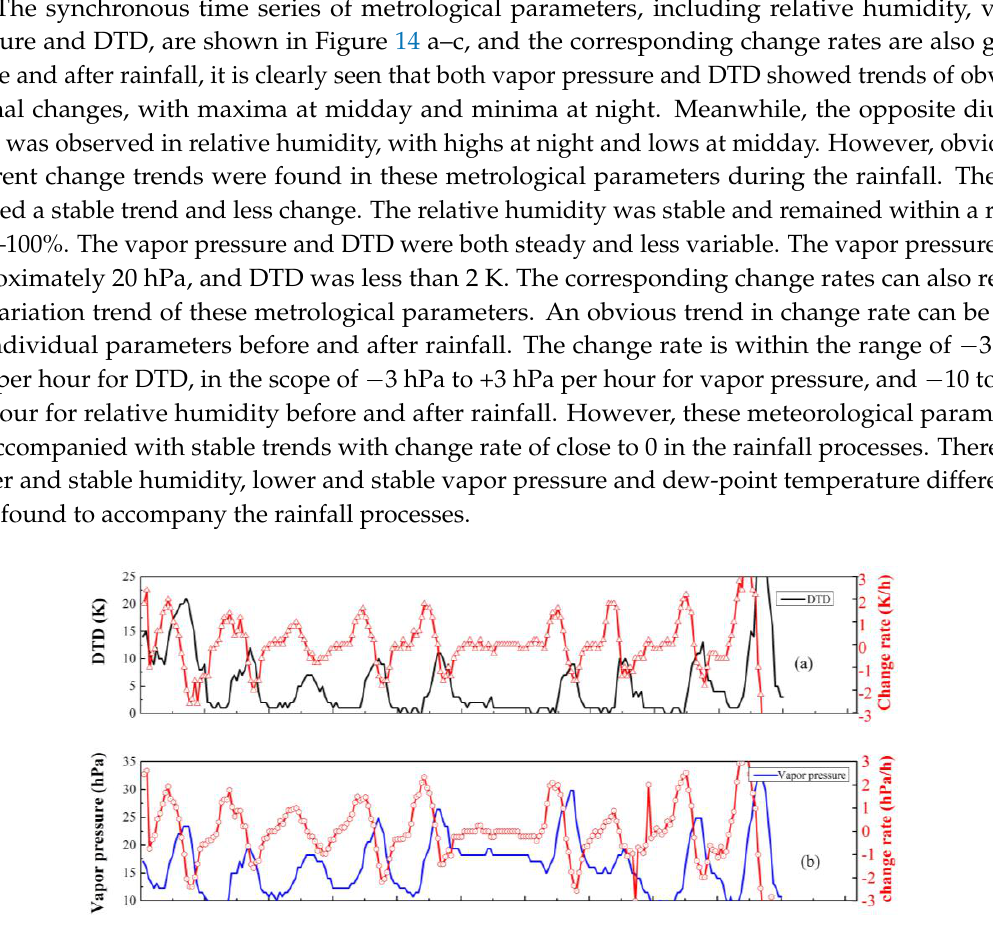
Figure 14 . Time series of meteorological parameters and the corresponding change rates during rainfall case. ( a ) dew-point temperature difference; ( b ) vapor pressure; ( c ) relative humidity.